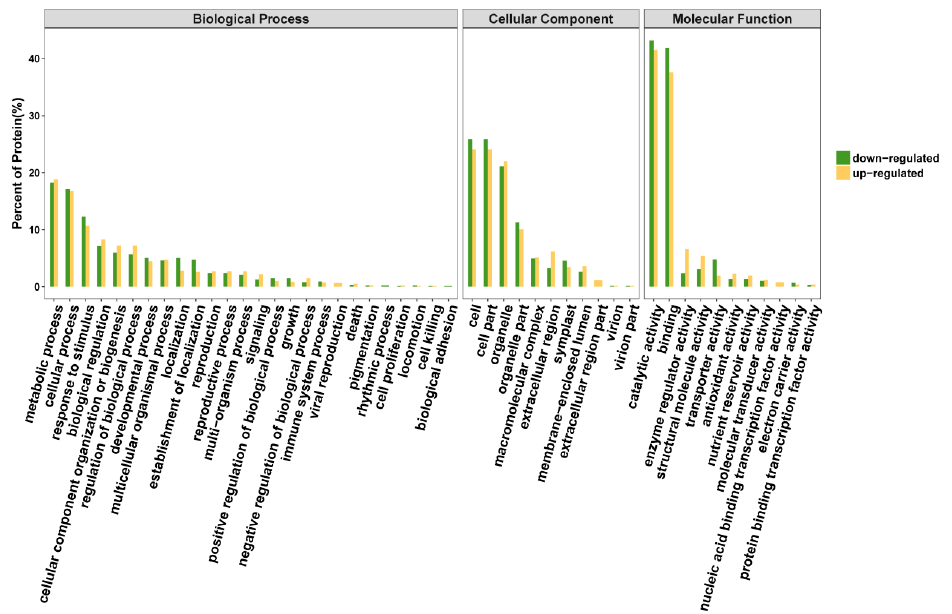
Figure 5. Gene ontology classification of DEPs between S727 and S3057. Biomolecules 2019 , 8 , x FOR PEER REVIEW